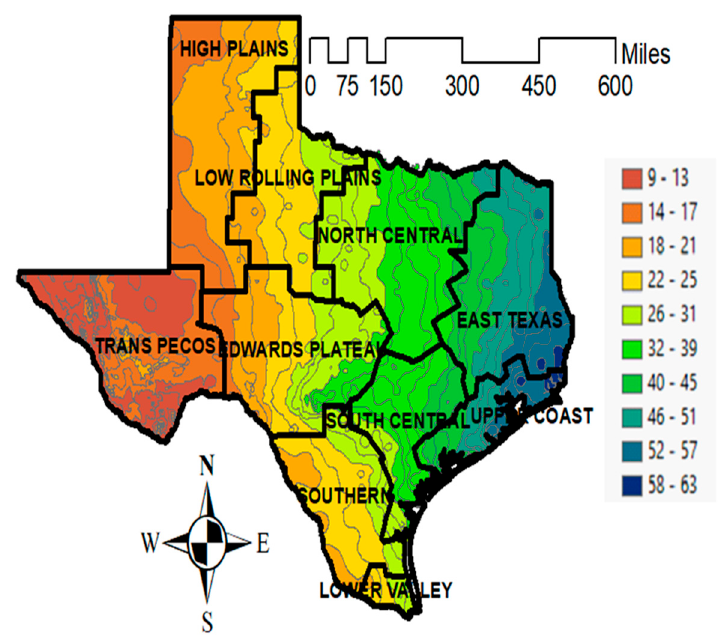
average crop yield from 1973 to 2000 (based on maximum 4-day total precipitation).